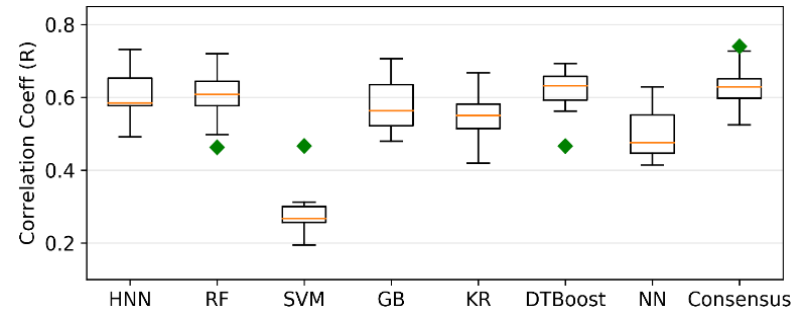
Figure 5. Correlation coefficient (R) of regression models developed based on HNN-Cancer, RF, SVM, GB, KR, DTBoost, NN, and consensus methods that predicts the carcinogenicity in mmol/kg body wt/day.